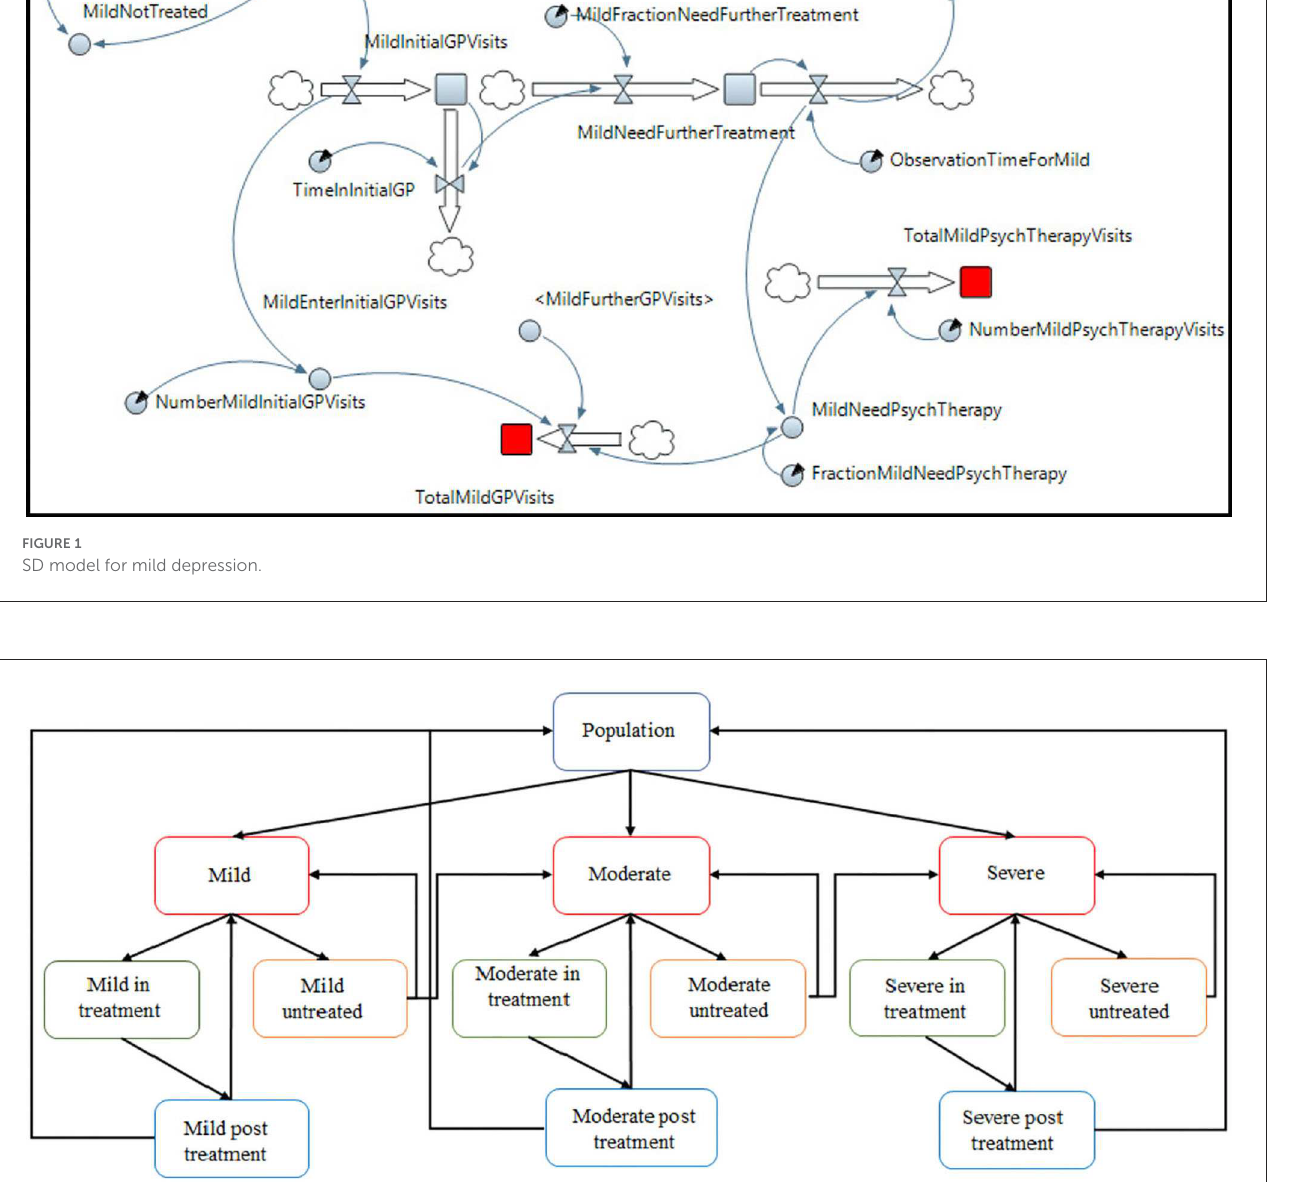
(or is not yet diagnosed). At each time step t ( t = 1, ..., T ), individuals can develop the disease, where time progresses in weekly steps. The transition to (1) mild, (2) moderate, and (3) severe depression is governed by the estimated prevalence of depression in the population (represented by p ∈ [0, 1]) and the estimated proportions in developing respective symptoms,